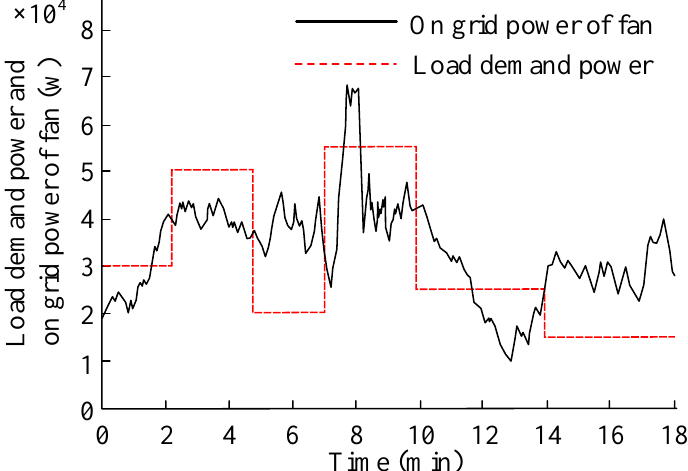
Figure 6. Comparison diagram of load demand and grid connected power of wind turbine.